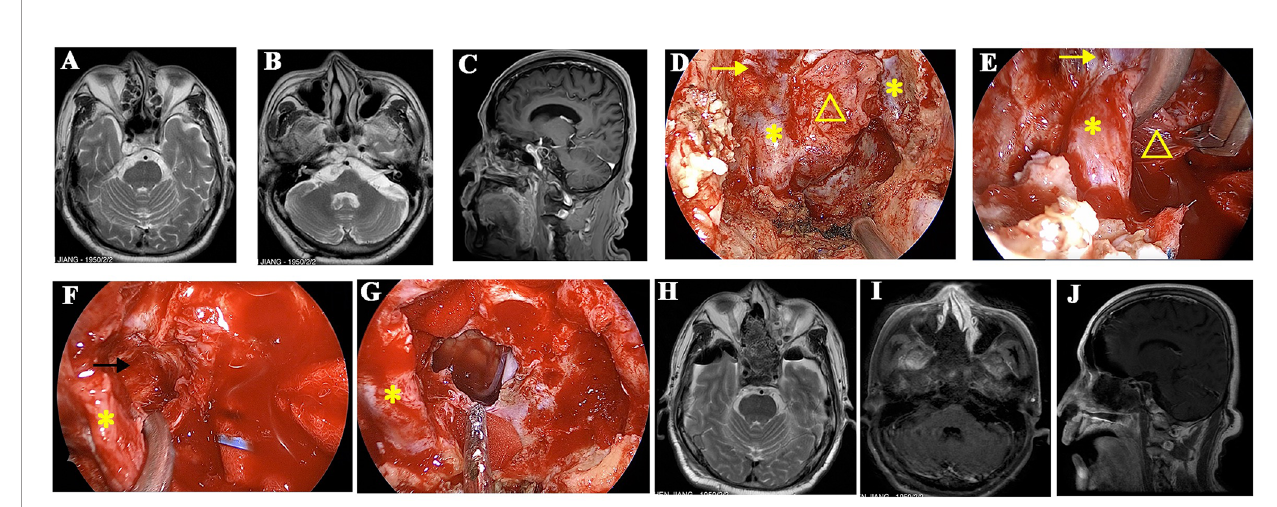
FIGURE 3 | A recurrent chordoma locates in the upper and mid-clivus. (A, B) The axial MR images show that the tumor locates in the right posterior space of cavernous ICA and the right posterior space of paraclival ICA, respectively. (C) The sagittal view shows that the tumor locates in the upper and mid-clivus and invades into the posterior space of paraclival ICA. (D) Intraoperative image shows that the bone covering the paraclival and lacerum ICA was drilled. (E) The paraclival ICA is gently retracted, and the tumor behind ICA was resected with the angled instruments under the view of 45° endoscopy. (F) The posterior space of cavernous ICA is seen after tumor resection, and the margin is clear. (G) The tumor is totally removed, and brain stem is visible. (H – J) Postoperative MR images showed that the tumor was totally removed. The yellow arrows represent cavernous ICA. The yellow triangles represent the recurrent chordoma. The yellow asterisks represent paraclival ICA. The black arrow represents the posterior space of the cavernous